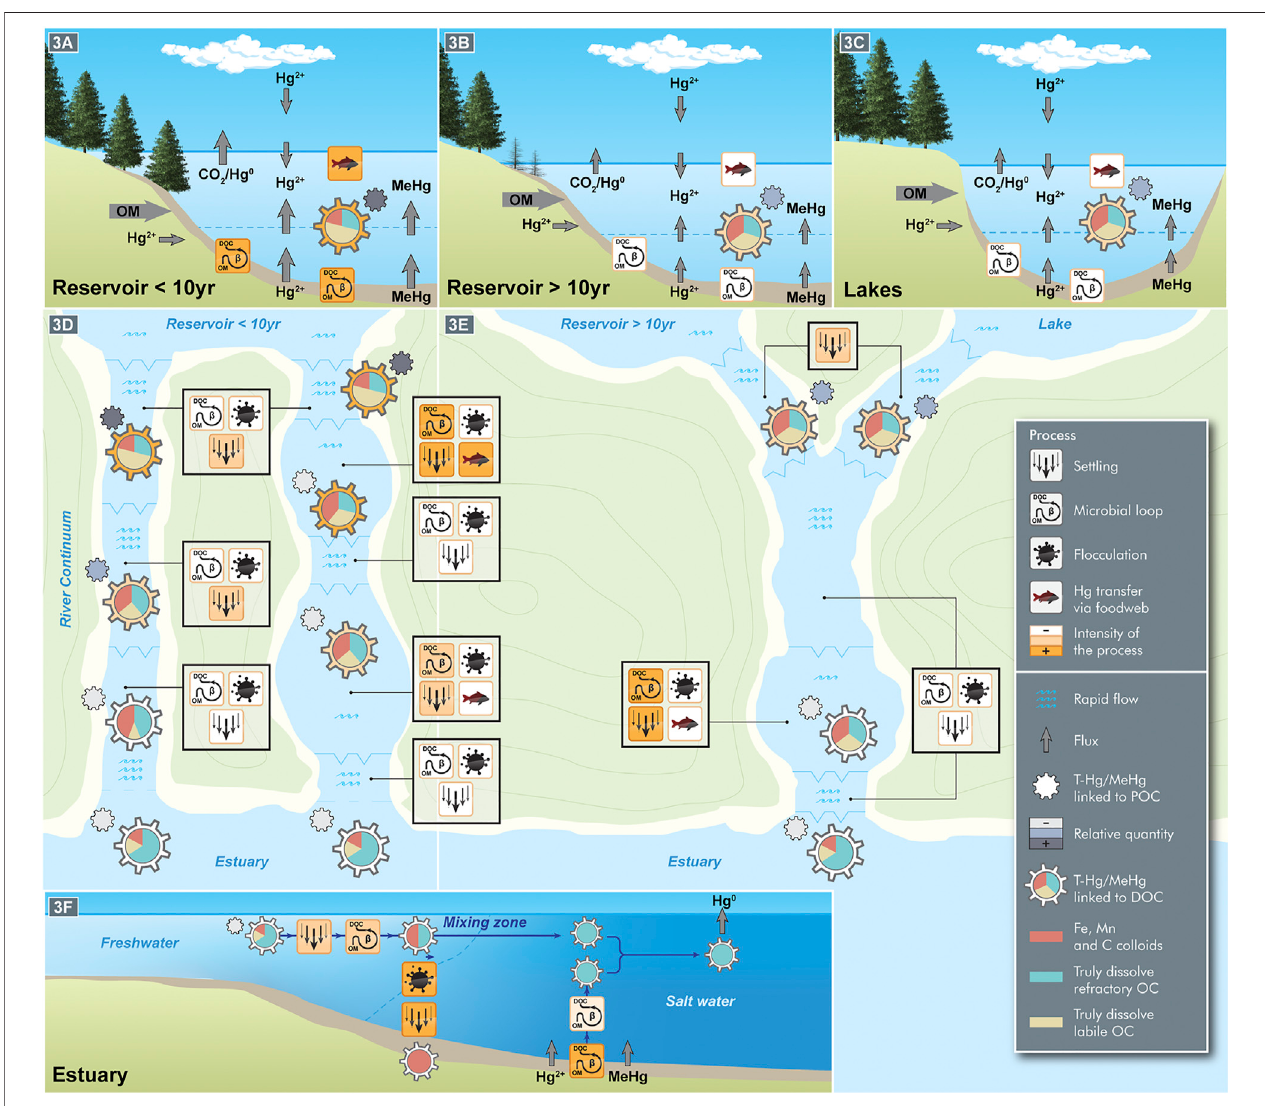
FIGURE 1 | Conceptual summary of the fate of carbon and mercury compounds in their transport from reservoirs and lakes to estuaries through different river continuums. The magnitude of the physical, chemical and biological processes and fl uxes depends on ecosystem type: young reservoir (A) , old reservoir (B) , lake (C) , riverwithorwithoutriverinelakes (D,E) ,andestuary (F) .Youngreservoirs( < 10 years)presenthigherbacterialactivity,whichleadstohigherconcentrationsofthestudied components, namely total mercury and methylmercury (T-Hg/MeHg) linked to particulate organic carbon (POC) or to dissolved organic carbon (DOC). The dissolved fraction is detailed according to its speciation, i.e., molecular size and lability: colloids (size fraction between a few nanometers and 0.45 µm); truly dissolved (size fraction < 0.45 µm) but refractory OC; and truly dissolved (size fraction < 0.45 µm) labile OC, this latter being rapidly consumed by heterotrophs. As indicated in the Conclusion herein, T-Hg/MeHg linked to POC rapidly decreases along the aquatic continuum owing to settling and fl occulation. As for T-Hg/MeHg linked to DOC, the concentration decrease along the aquatic continuum is intimately related to DOC speciation: colloids tend to fl occulate; labile DOC enters the bacterial loop and